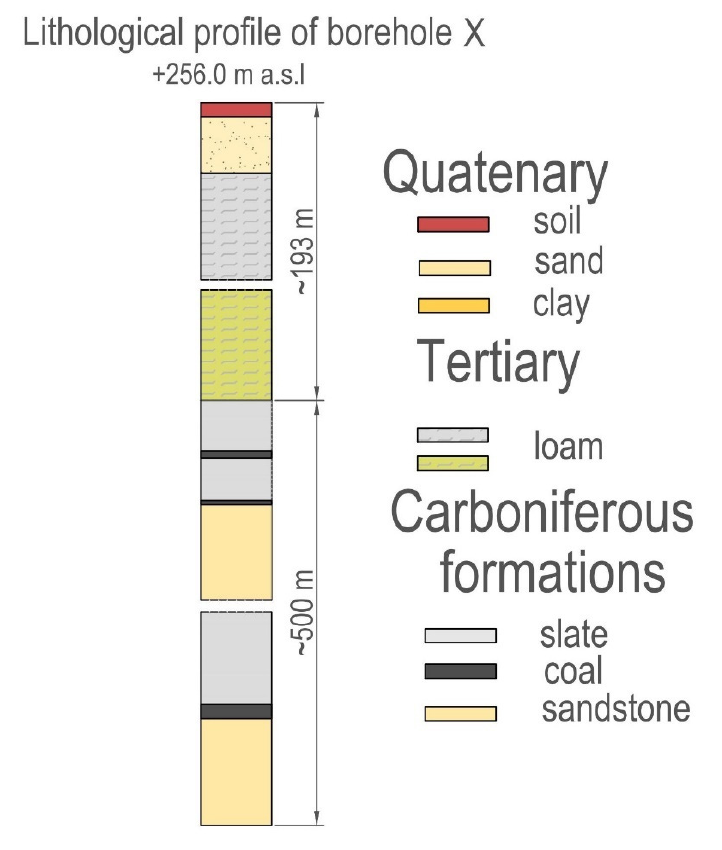
Figure 11. Lithological profile of borehole X.